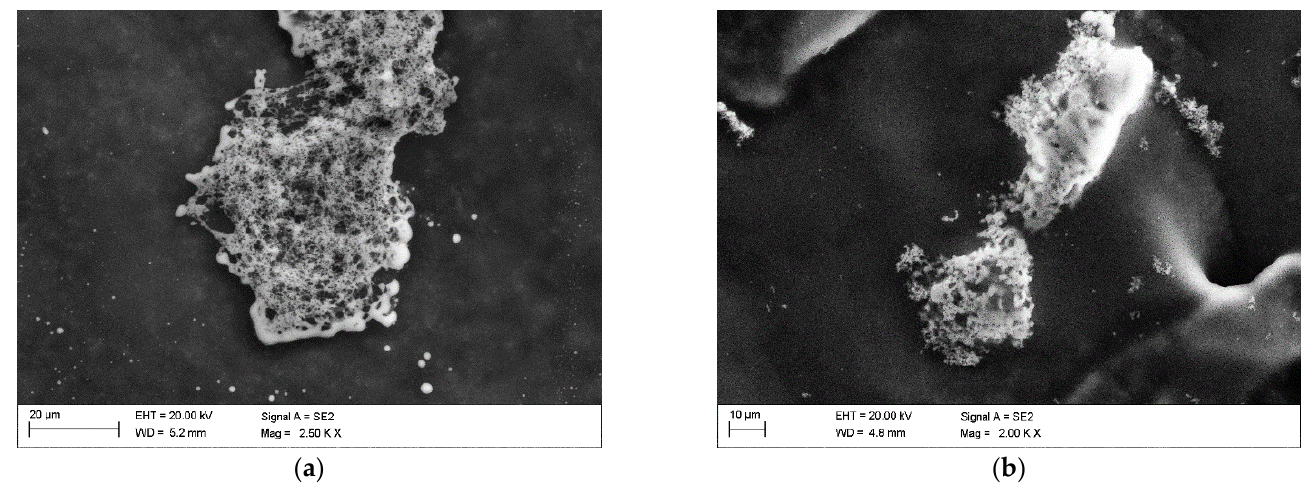
Figure 2. Morphology of the: ( a ) leachate, ( b ) control solution, SEM (SE).